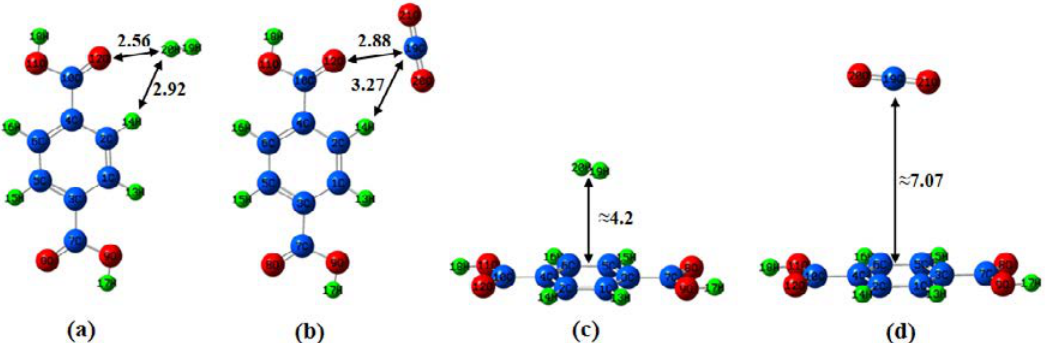
Fig. 4: Relaxed configuration of (a) H